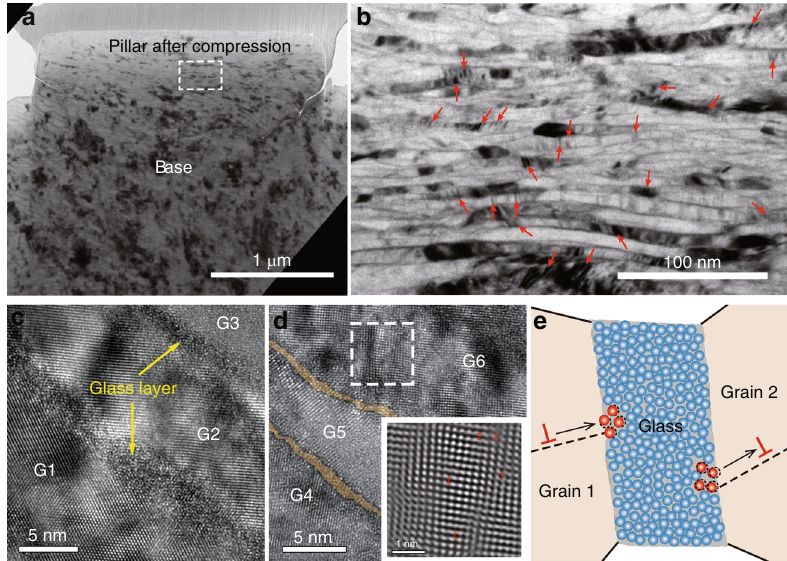
Fig. 4 Plastic deformation mechanism of the hierarchical nanostructured Al alloy. a Cross-sectional TEM image of a 1 μ m-diameter pillar after compression. b Enlarged TEM image from white dashed rectangle area in ( a ). The red arrows indicate the positions of some dark regions. c HRTEM image near nano- lamellar grains G1, G2, and G3, clearly demonstrates the existence of the amorphous phase (glass layer) after deformation. d HRTEM image near nano- lamellar grains G4, G5, and G6. The nano-sized MG phase is colored by light yellow. The lower right inset is inverse Fourier transformation (IFT) image of the dashed square area in the main image, showing some of the dislocations ‘ ┴ ’ . e Illustration of dislocations ’ activities interacted with the nano-sized MG phase. A dislocation ( ‘ ┴ ’ ) is generated on the glass-grain 2 interface and then moves inside grain 2. Another dislocation ( ‘ ┴ ’ ) moves inside grain 1 and then is absorbed by the atoms on the edge of the nano-sized MG phase (dislocation annihilation). The red and blue spheres represent mobile and less mobile atoms respectively. The dashed circles represent the original positions of the mobile atoms. The black arrows denote the motion directions of the